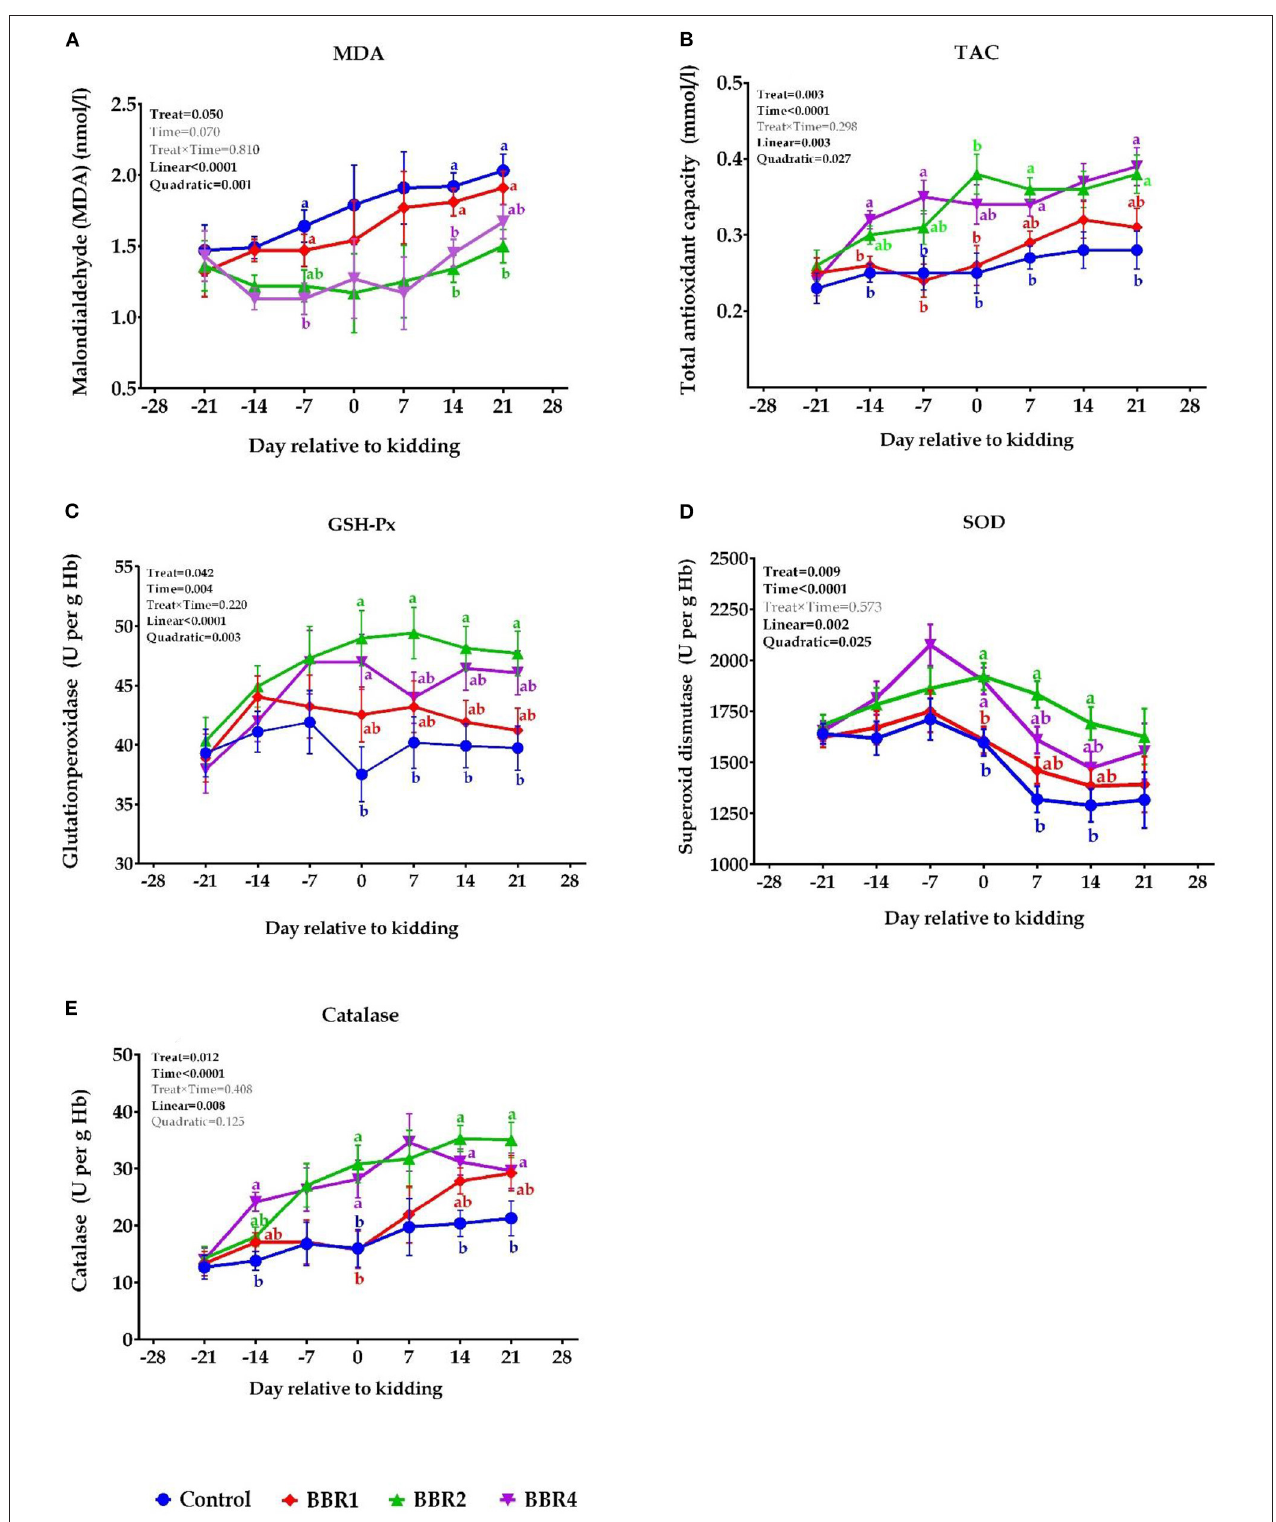
FIGURE 2 | Dynamic effects of BBR supplementation on the levels of (A) MDA, (B) TAC, (C) GSH-Px, (D) SOD, and (E) catalase in Saanen dairy goats supplemented with different levels of BBR during the transition period. a,b Values with different superscript letters at the same time point are significantly different ( P ≤ 0.05).